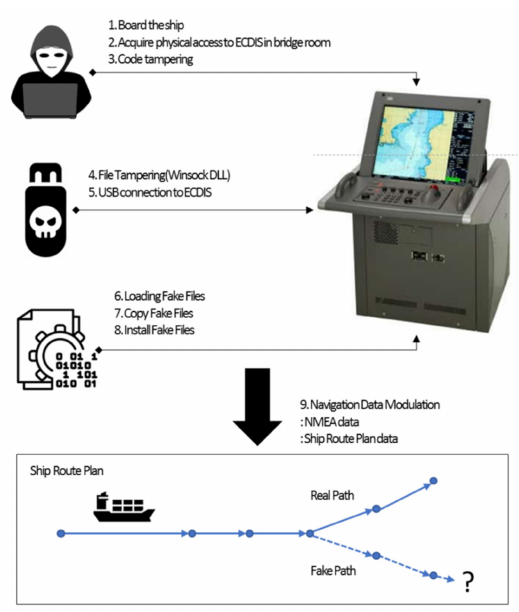
Figure 5. Scenario of attack case